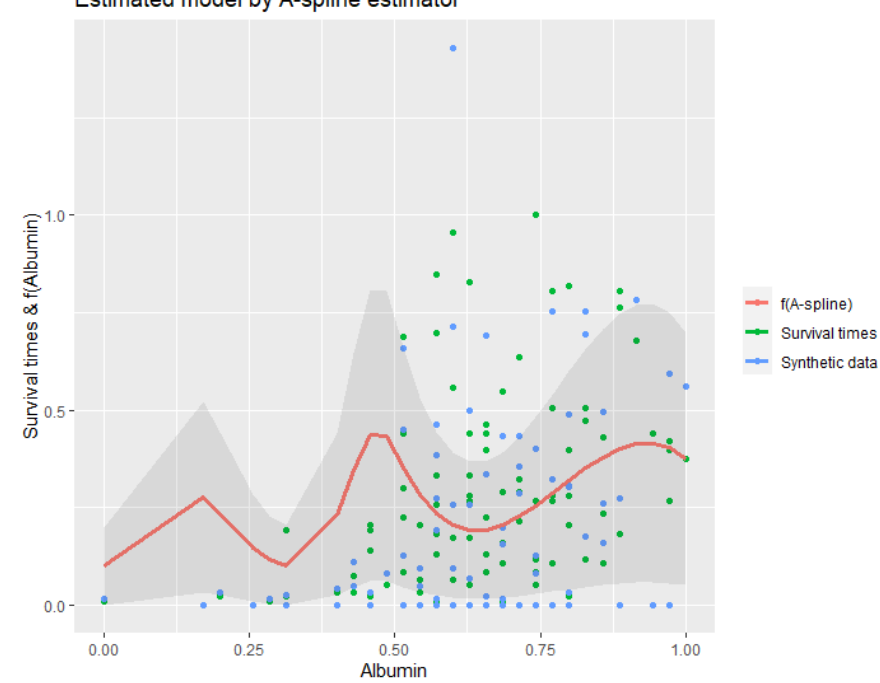
Figure 6. Estimated model for cancer data by the A-spline estimator.